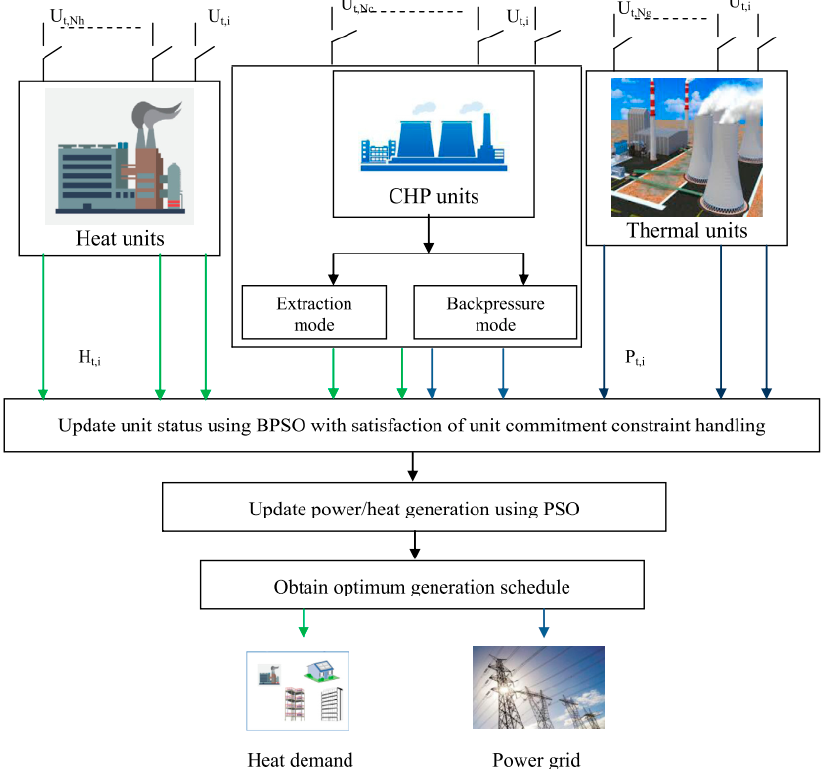
Figure 11. The process of optimal scheduling of a dual-mode CHP plant, with thermal and heat units, solved by combination of the binary PSO and PSO methods [166].